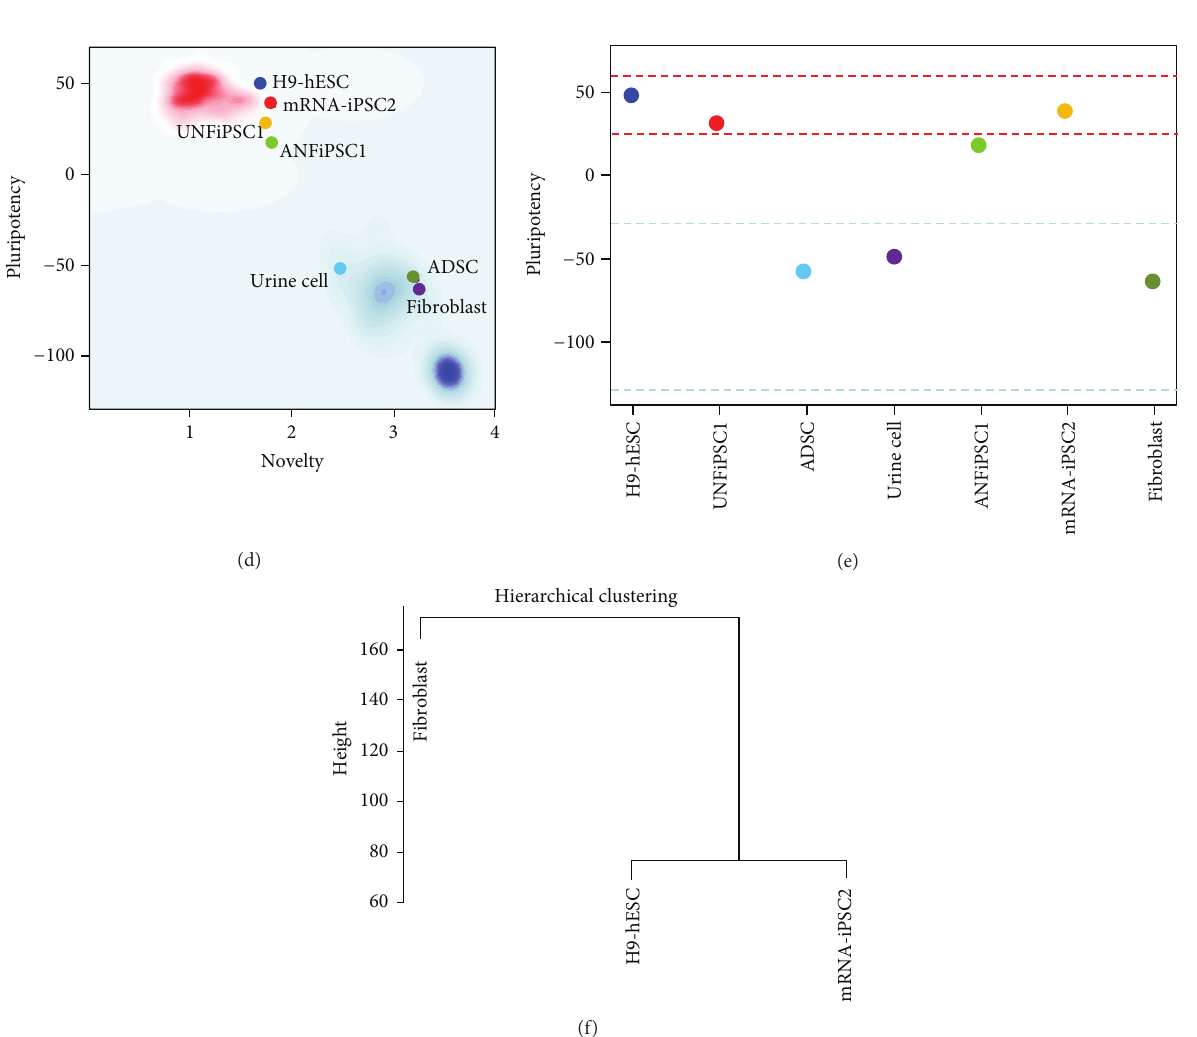
Figure 4: Genome-wide gene expression profiling of the mRNA-iPSCs. (a-b) Scatterplot analysis showed that the global gene expression pattern of mRNA-iPSCs is similar to that of H9-hESCs (a). However, the gene expression patterns are clearly different between mRNA- iPSCs and their parental cells, fibroblasts (b). (c) Heatmap analysis indicated that the expression patterns of 100 hESC-enriched genes and 100 human fibroblast-enriched genes (Supplementary Table 4) in mRNA-iPSCs were similar to those in H9-hESCs but not fibroblasts. (d-e) PluriTest analysis showed that mRNA-iPSCs and other previously established iPS cells (UNFiPSC1 and ANiPSC1) [18] were clustered with H9-hESCsinthepluripotentgroup,whereasfibroblastsandotherprimarycellswereclusteredinthenonpluripotentgroup.(f)Geneprofiling- based hierarchical clustering analysis demonstrated the close association of the mRNA-iPSCs with H9-hESCs but not with the primary cells